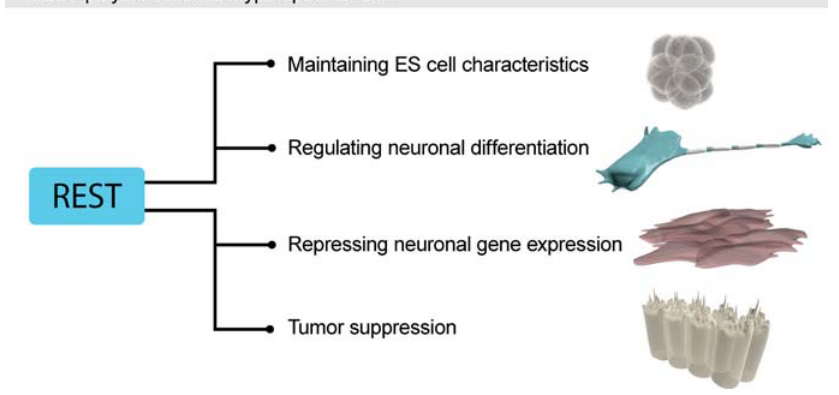
Figure 2. A Schematic Summary of Some Cell Type–Specific Roles for REST Recent reports show a novel role for REST in maintaining ESC phenotype by being a close part of the core transcriptional network of Oct4/Sox2/Nanog in ESCs (see text). REST has previously been suggested to repress neuronal differentiation in NSCs and medulloblastoma cells, in addition to its well- established role in repressing neuronal genes in non-neural cells. REST has also been shown to act as a tumor suppressor by repressing epithelial cell transformation, a role that could be linked to the regulation of cell adhesion genes (see